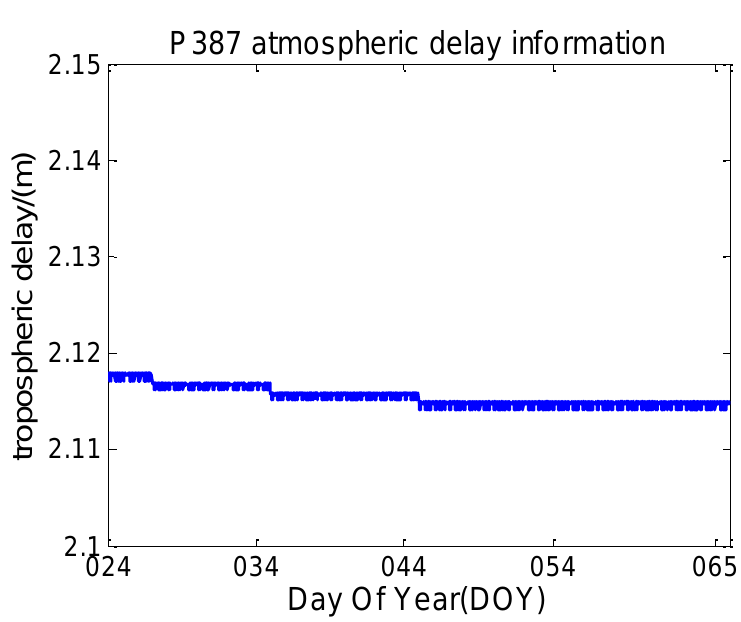
Figure 3. Snow depth of P387 in the experimental period.